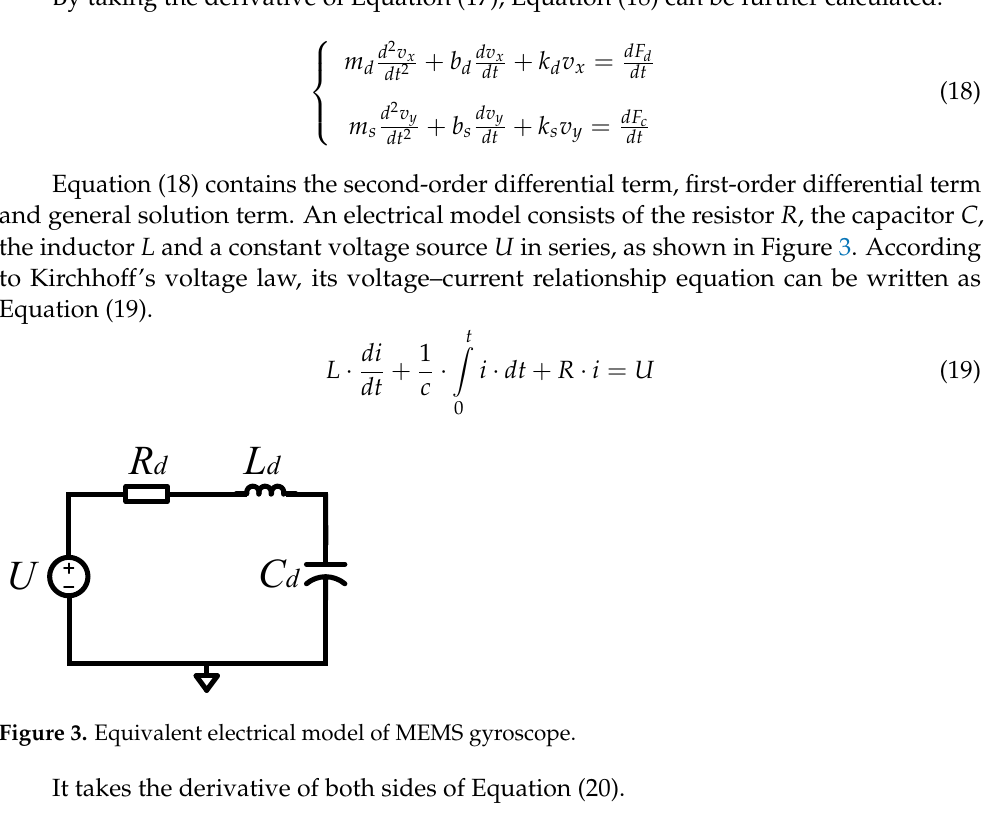
− Figure 4. Equivalent electrical model of mechanically sensitive structure of gyroscope.